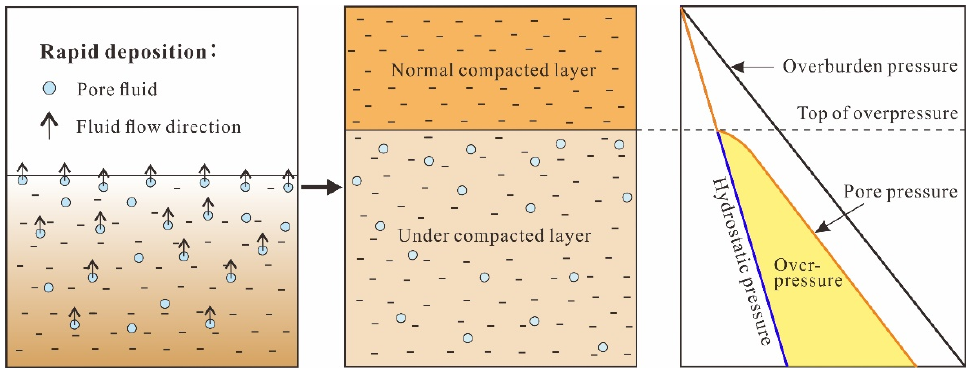
Figure 2. Schematic diagram for overpressure development associated with disequilibrium compaction.